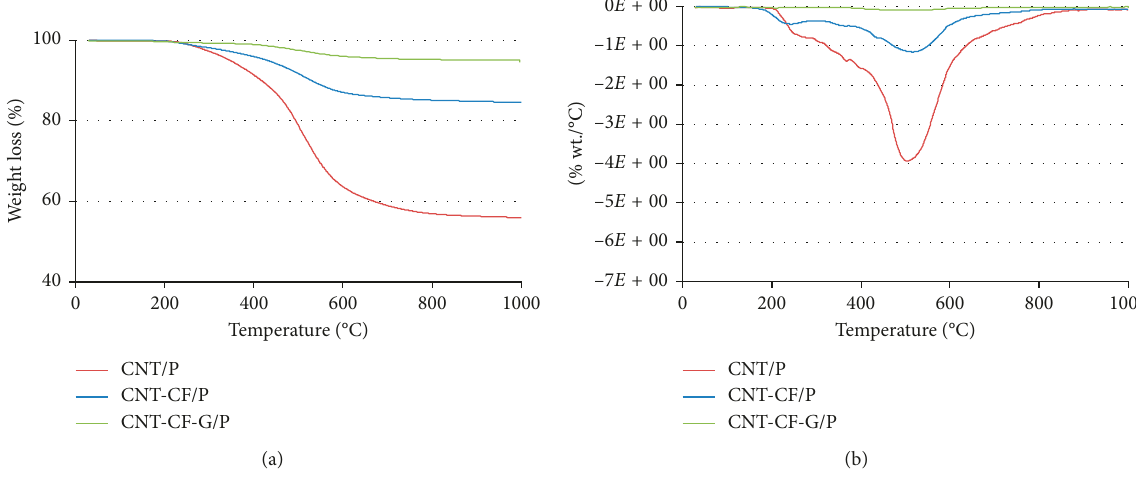
Figure 6: Thermal analysis of CNT/P, CNT-CF/P, and CNT-CF-G/P composites: (a) TGA diagram and (b) DTG